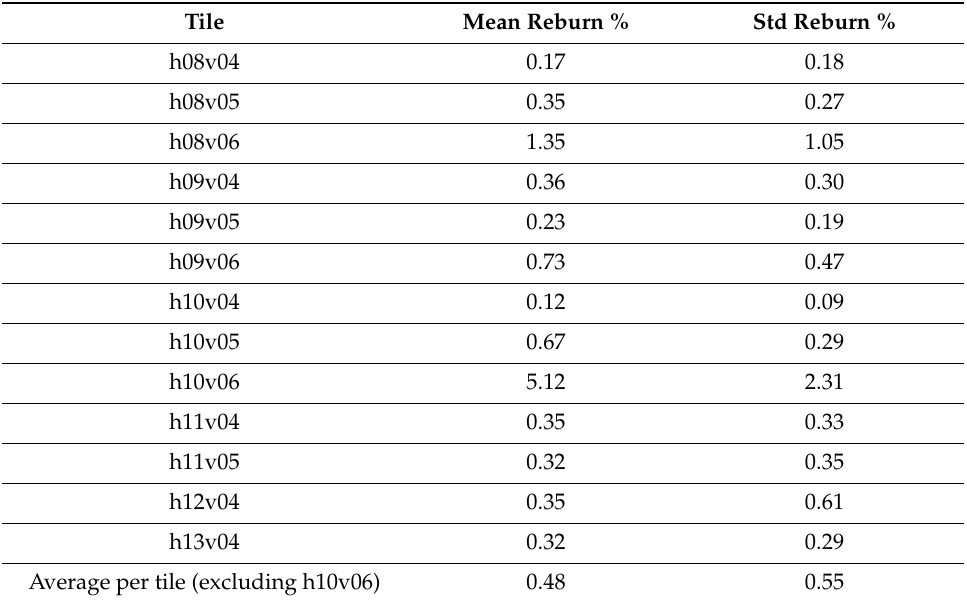
Table 2. Number of reburned pixels per year, per tile calculated for 2001–2018 from the monthly MODIS MCD64 burned area